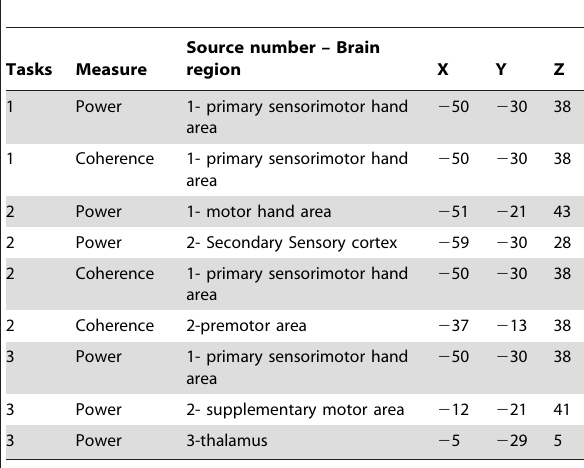
Table 2. MNI co-ordinates of the reference voxels chosen for the sources in each